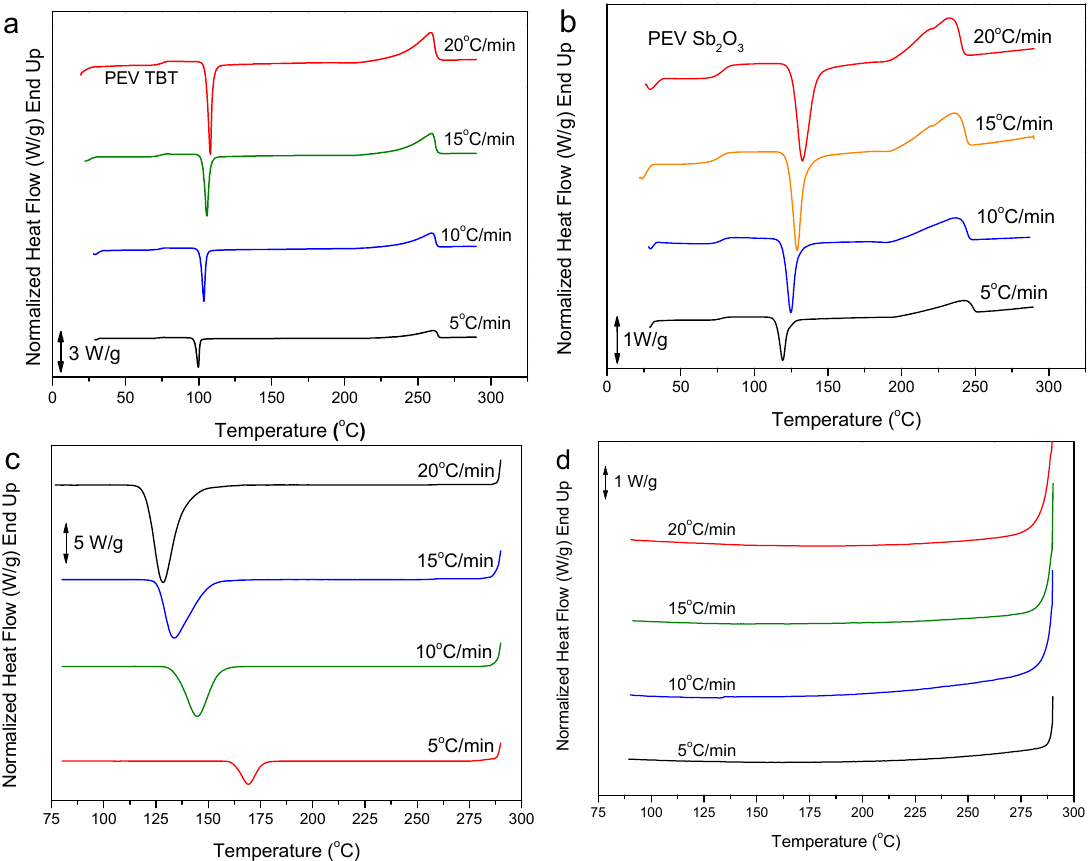
Figure 4. ( a , b ) heating scans at di ff erent rates for melt-quenched low and higher molecular sample, respectively, ( c , d ) cooling scans at di ff erent rates for the low and higher M w sample, respectively. The isothermal crystallization from the melt was studied for both samples at low temperatures (large supercoolings), because, in general, the process was slow. Slow crystallization was observed for the high molecular weight sample, while under low or even moderate supercoolings both the higher and the lower M w samples could not crystallize fast (Figure 5a,b). In accordance with the previously discussed findings, the crystallization of the higher M w sample was much slower, as can be concluded given the large di ff erences in the crystallization half-times presented in Figure 5c. In general, the crystallization half-times increased exponentially with temperature, as was